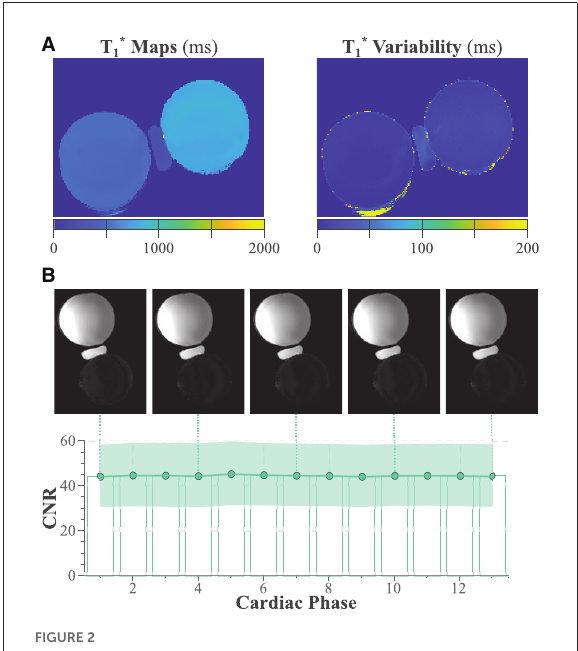
FIGURE2 (A) T ∗ 1 acquired in phantom with the proposed functional LGE sequence. The left panel shows the maps averaged across the simulated cardiac cycle, while the right panel displays the variability throughout the cardiac cycle. (B) Phantom functional LGE images with the synthetic inversion time chosen to null the myocardial (lower) sphere. The contrast to noise ratio between the two spheres is plotted throughout the simulated cardiac cycle. Shading indicates the spatial variability across the manually drawn